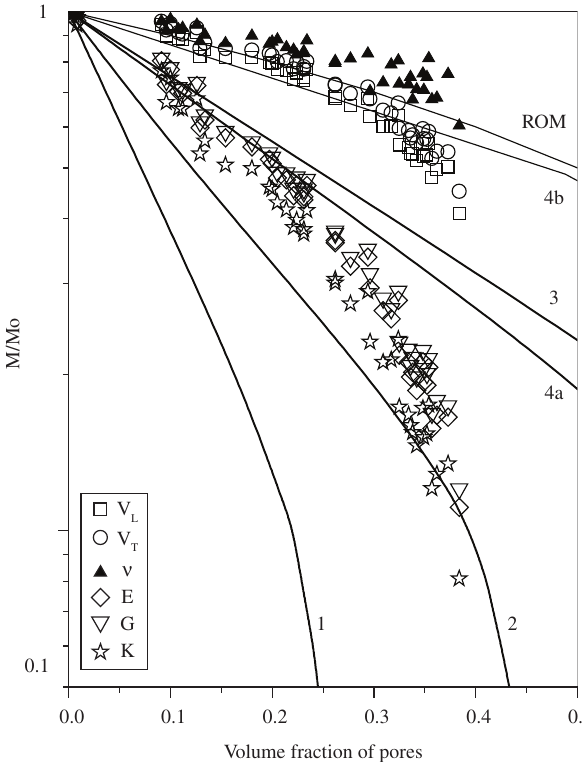
Figure 5. Relative elastic constants versus porosity. The curves indicated by numbers are minimum solid area (MSA) models: 1 - spherical particles in rhombohedral stacking; 2 - spherical particles in cubic stacking; 3 - spherical pores in cubic stacking; 4a - cylindrical pores in cubic stacking aligned trans- versal to applied stress; and 4b - cylindrical pores in cubic stacking aligned parallel to applied stress. The curve indicated by ROM is rule of